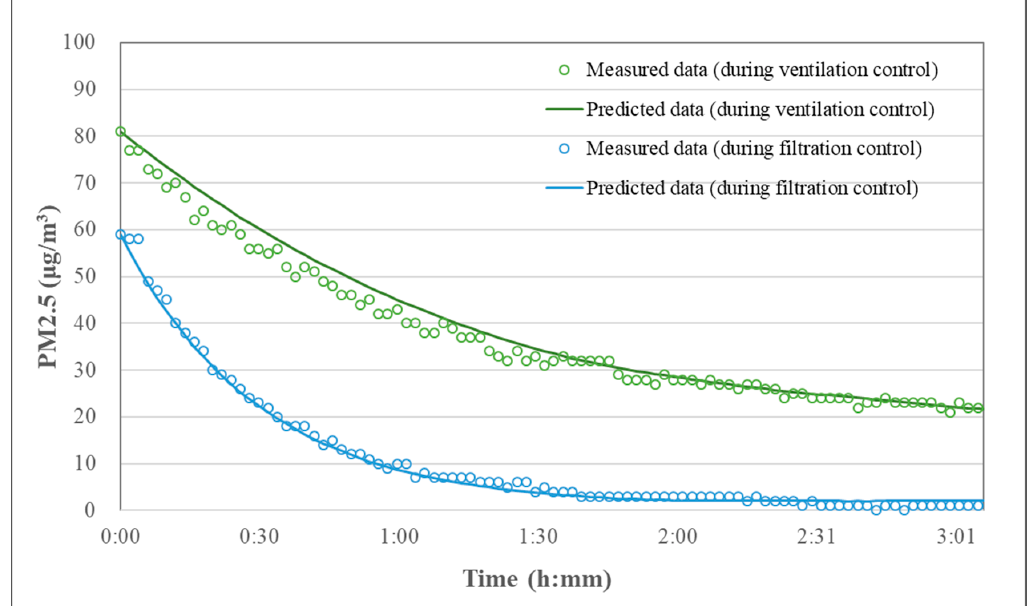
Figure 4. Comparison of measured and predicted data.